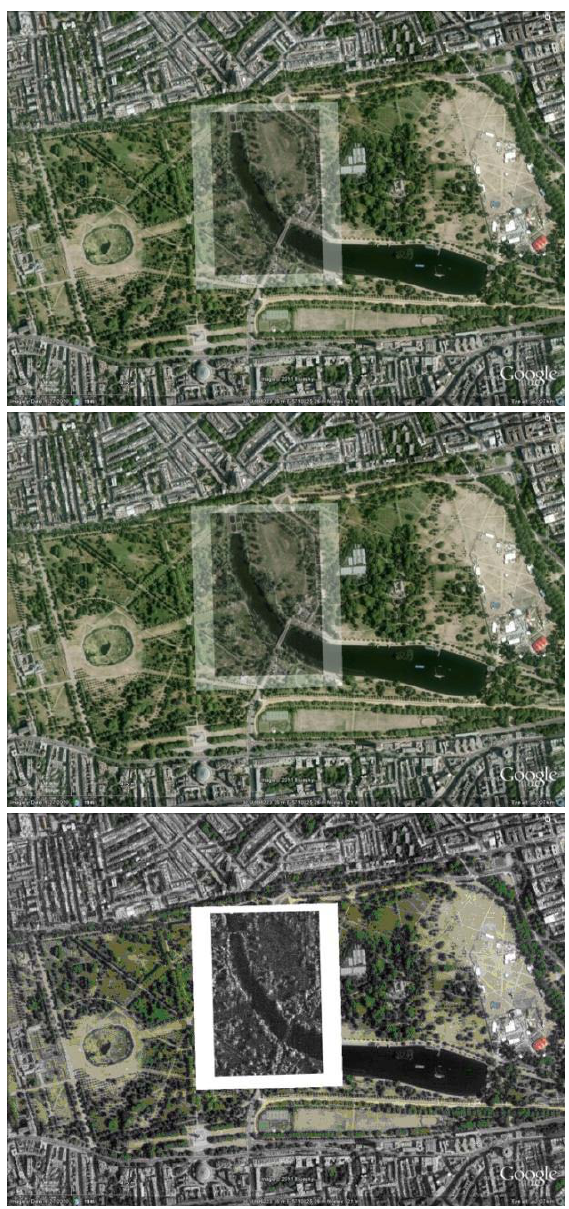
Figure 3.Realization of the 4D tensor by projection of the cropped X-SAR image on Google Earth, to illustrate the coherence of the projection we display different opacity levels.